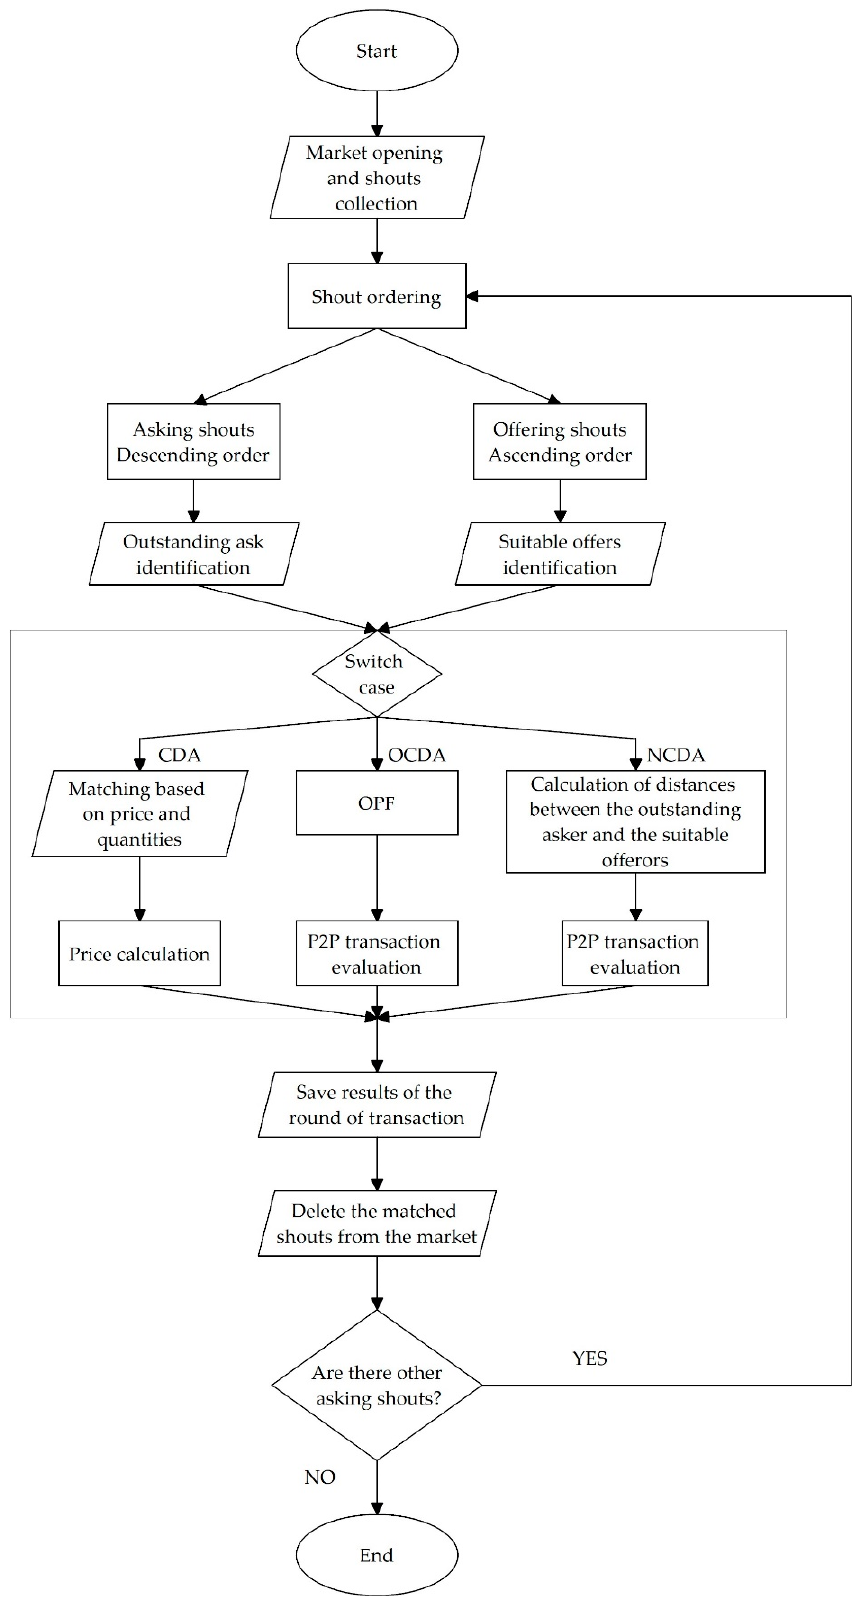
Figure 2. The flowchart of the methodology proposed in this paper for comparing CDA, OCDA, and NCDA.